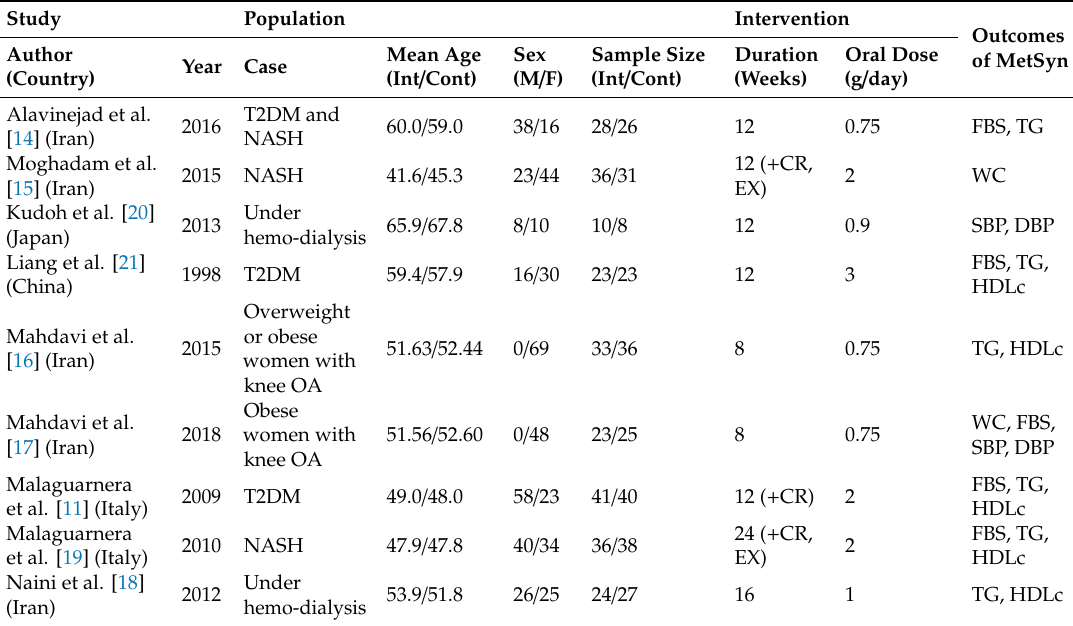
Table 1. Characteristics of the included studies.